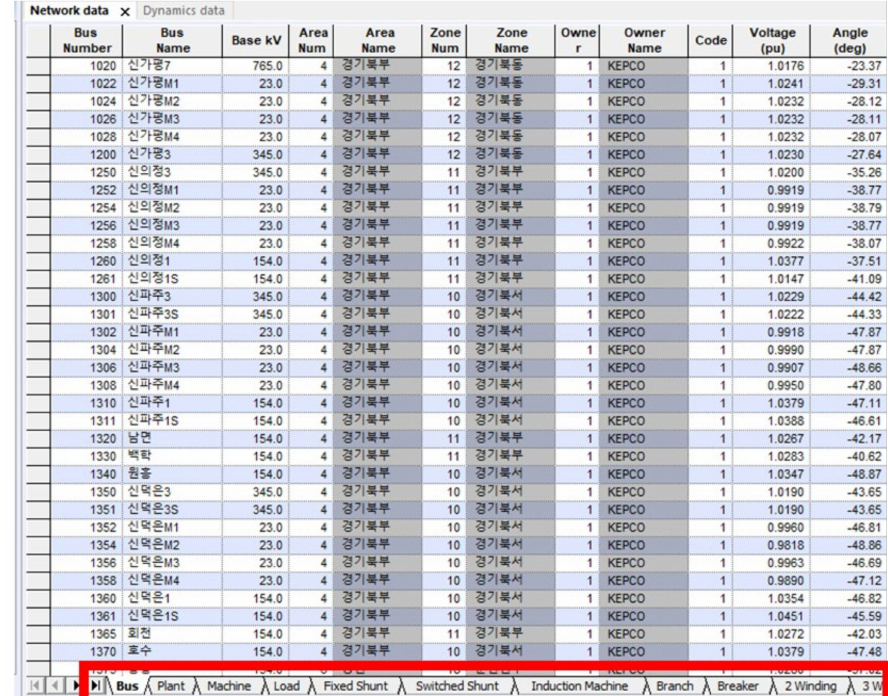
Figure A3. Static DB based on PSS / E